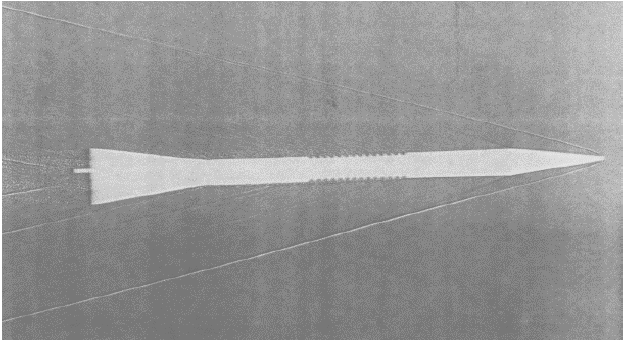
Fig. 1. Jump test instrumentation.